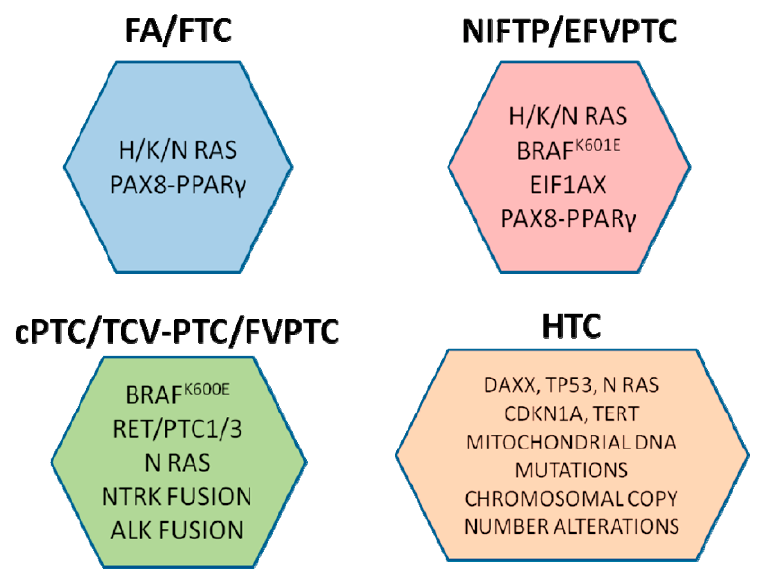
Figure 6. Synopsis showing the main biomolecular mutations in DTCs related to different histotypes. Consequently, it may be suggested that tumor genotype is associated with peculiar phenotype; therefore, the identification of DTC morphology may be the driver to select different neoplastic portions in which molecular heterogeneity could be revealed. From this point of view, neoplastic sub-populations with different risk of recurrence or metas- up period. Recently, to measure ITH in cancer, an index has been proposed [119]; in detail, some neoplasms such as uterine carcinosarcoma, colorectal adenocarcinoma and ovarian cancer have been observed to be more heterogeneous than renal clear cell carcinoma and DTC [119].